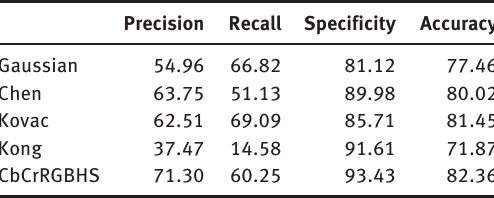
Table 7. Accuracy Results for Other Methods on the UCD Database.